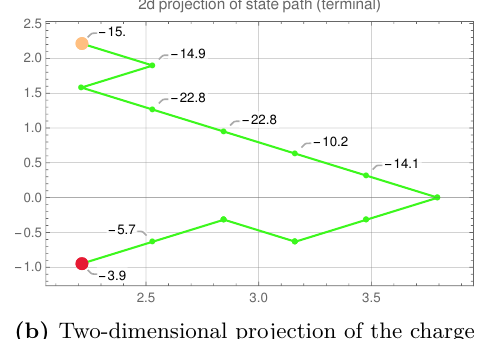
(b) Two-dimensional projection of the charge matrices Q t of the episode connecting the ini- tial state (4.5) (yellow dot) with the final state (4.6) (red dot). The labels indicate the intrinsic values.